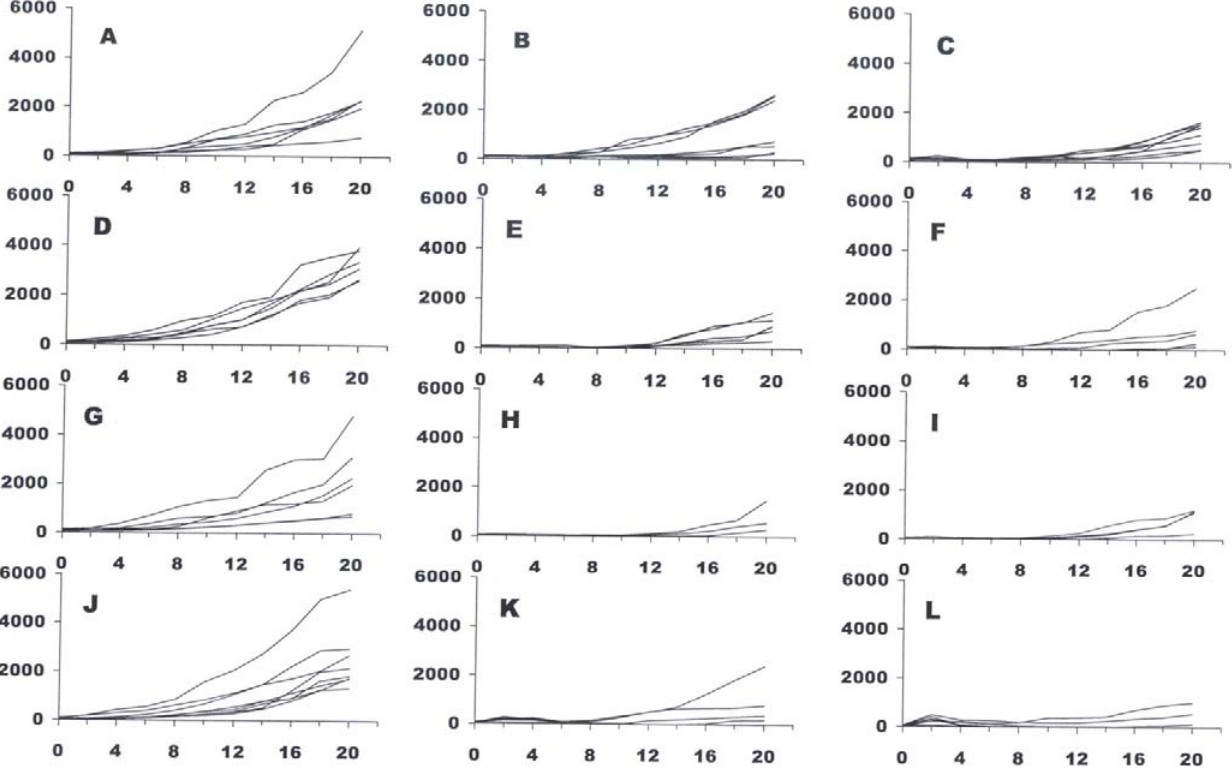
Figure 1. Determination of appropriate electrical parameters for an effective tumor treatment by IRE – experiments with immunocompetent mice. Panels are identified by letters corresponding to the parameters described in table 1, except for panel A (tumor growth in untreated mice followed as controls of treatment conditions B and C), panel D (control of E and F), panel G (control of H and I) and panel J (control of K and L).